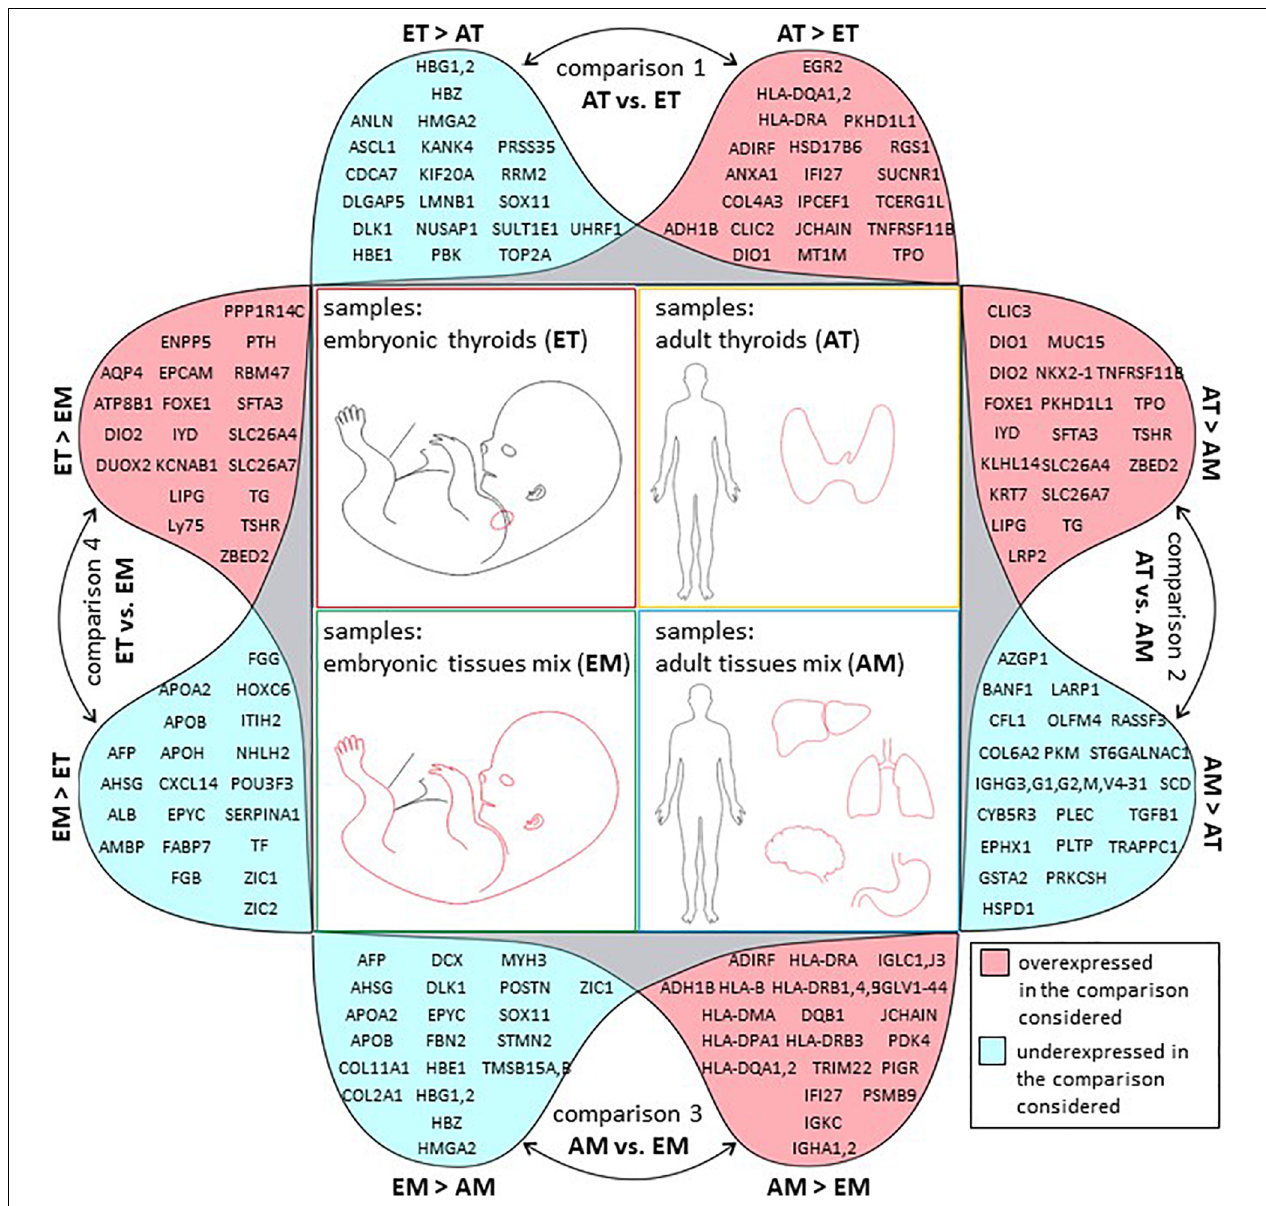
FIGURE 6 | Top 20 regulated genes in all comparisons. Graphical representation of tables of top 20 protein-coding genes with strongest up (in pink) or downregulation (in blue) in each of the four comparisons of transcriptome datasets described in this study. Comparison 1: transcriptomes of adult thyroids (AT) and embryonic thyroids (ET), comparison 2: transcriptomes of adult thyroids (AT) and adult tissues mix (AM), comparison 3: transcriptomes of adult tissues mix (AM) and embryonic tissues mix (EM), comparison 4: transcriptomes of embryonic thyroids (ET) and embryonic tissues mix